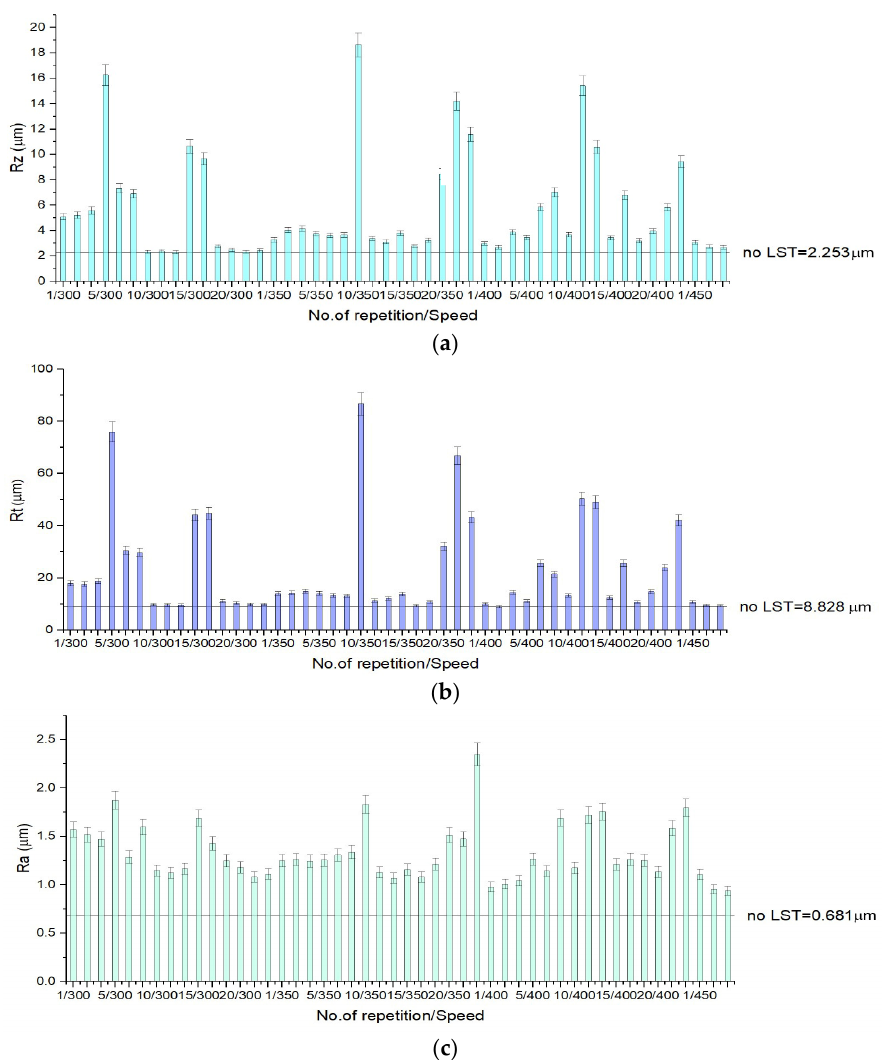
Figure 9. Surface roughness charts for design type B, R z —deviation from the mean line, specifically focusing on the highest peak and valley ( a ), R t —total height of the roughness profile of the deepest valley within the evaluation length ( b ) and R a —measures the average length between the peaks and valleys and the deviation from the mean line on the entire surface ( c